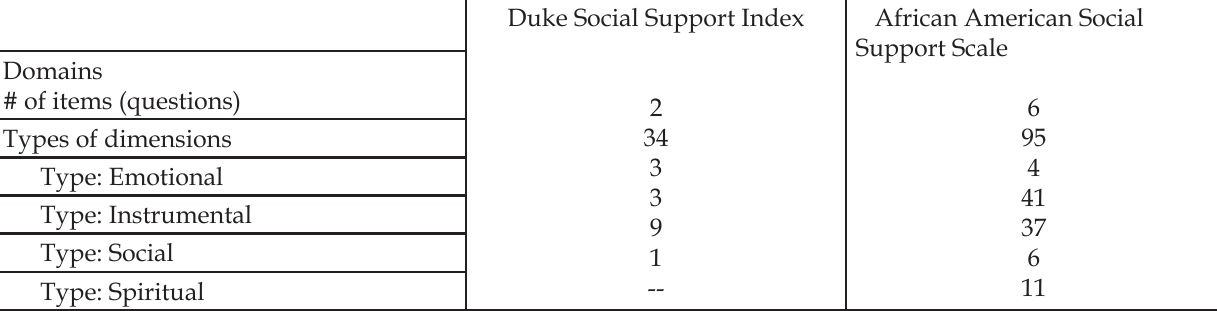
Table V. Comparison between Duke Social Support Index and African American Social Support